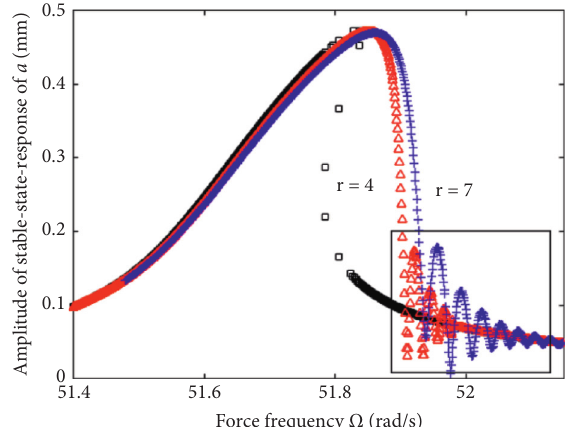
Figure 9: Amplitude frequency responses at different rates of damping change.